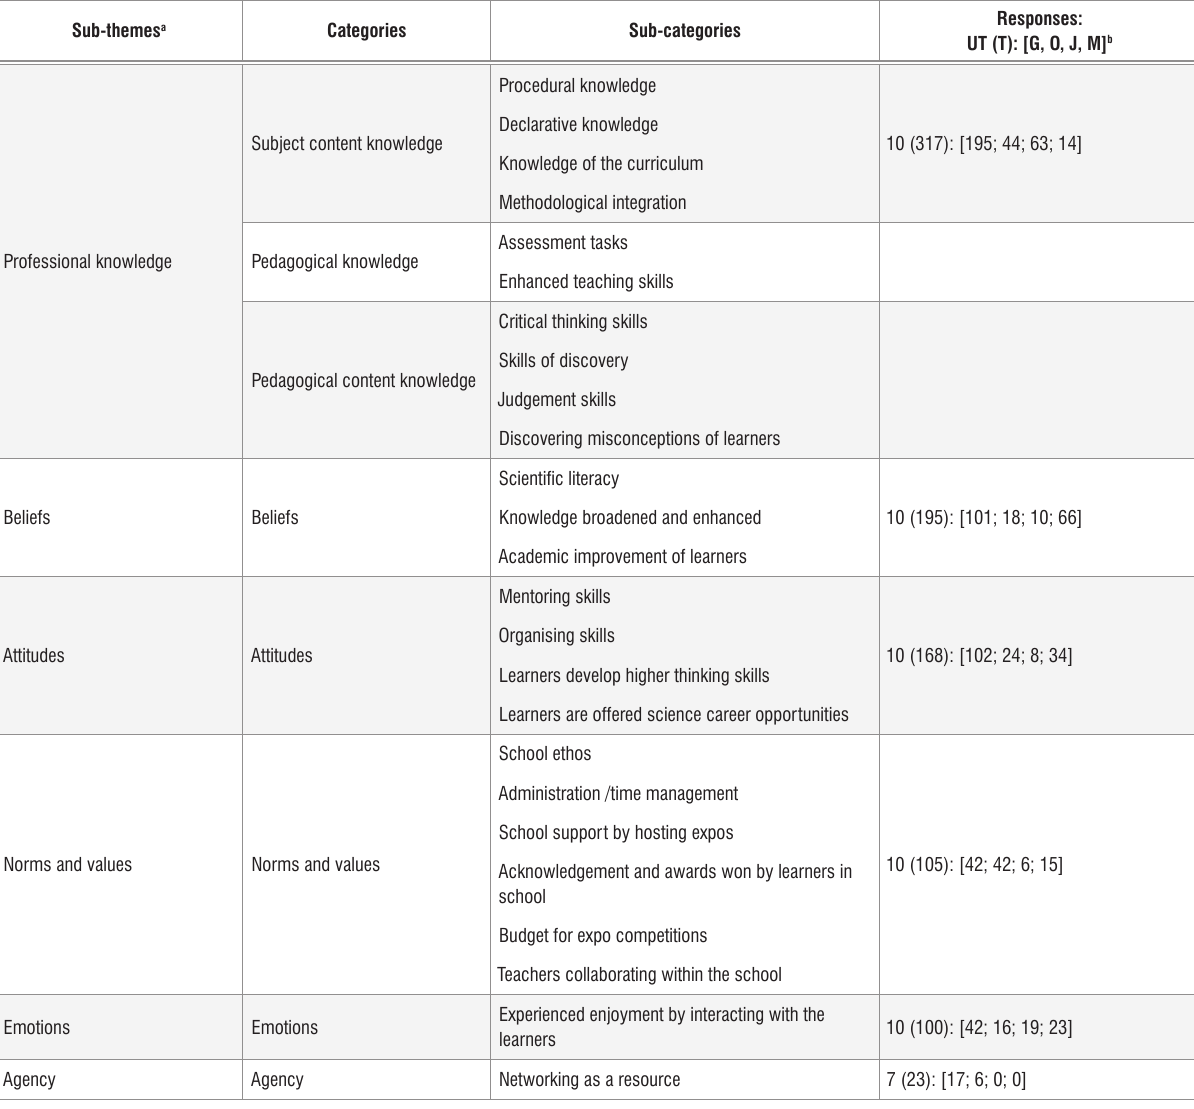
Table 2: Teachers’ participation in science Expos linked to their professional identity Sub-themes